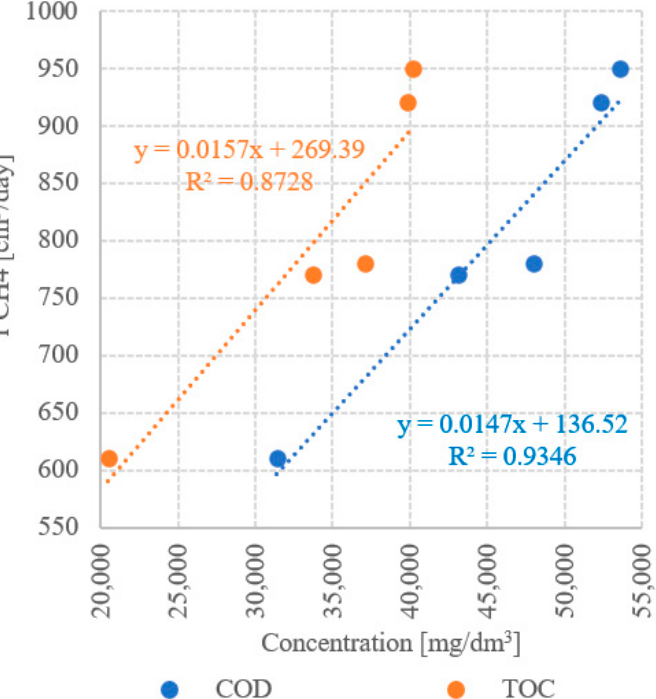
Figure 15. Correlation between concentration of dissolved organic compounds and CH 4 production rate.